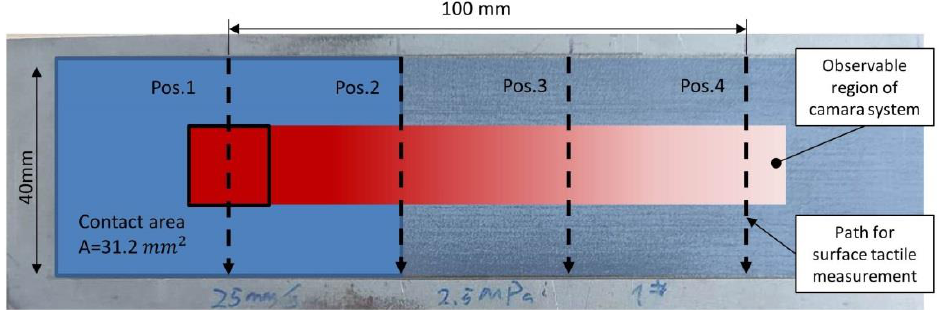
Figure 10. Positions of tactile roughness measurements of the sheet metal after a strip drawing test.